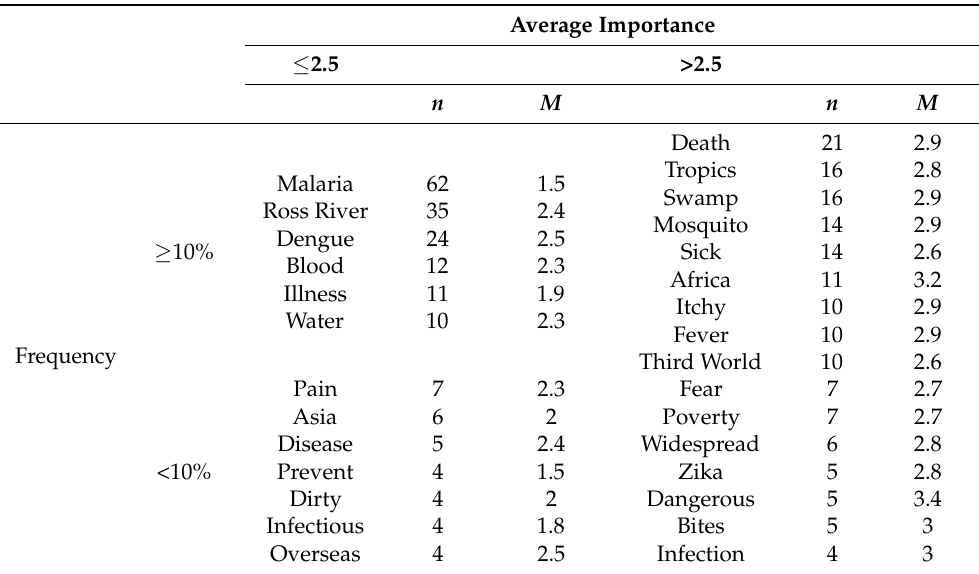
Table 1. General results in terms of frequency and average importance associated with the categories of words reported by